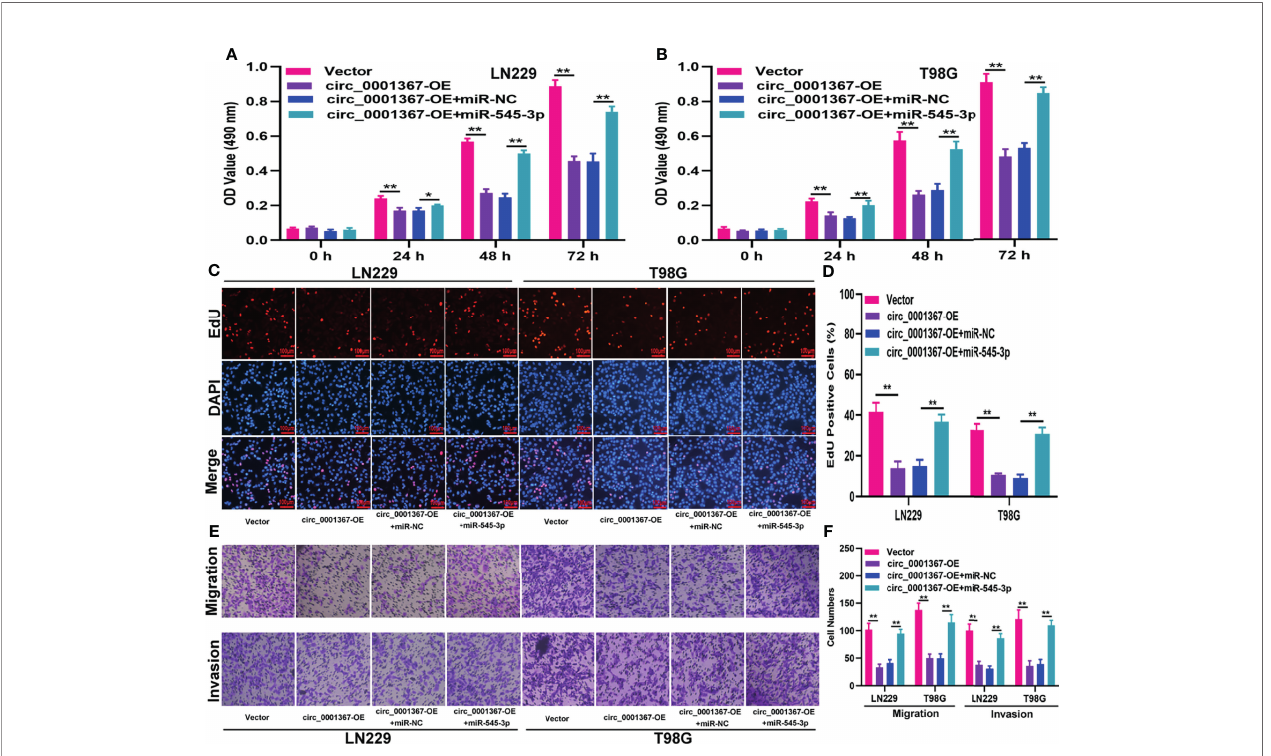
FIGURE 4 | Hsa_circ_0001367 suppresses glioma progression by absorbing miR-545-3p. (A, B) Cell proliferation was investigated by MTT assay after transfection. (C, D) Cell proliferation was tested by EdU assay after transfection. (E, F) Transwell assay was conducted to measure the migration and invasion capacity of T98G and LN229 cells after transfection. *P < 0.05, **P < 0.01.